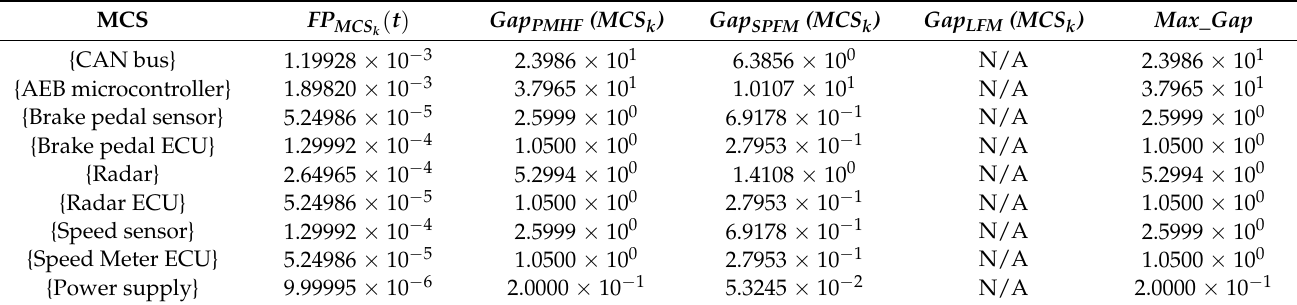
Table 12. List of MCSs and their failure probabilities for the AEB